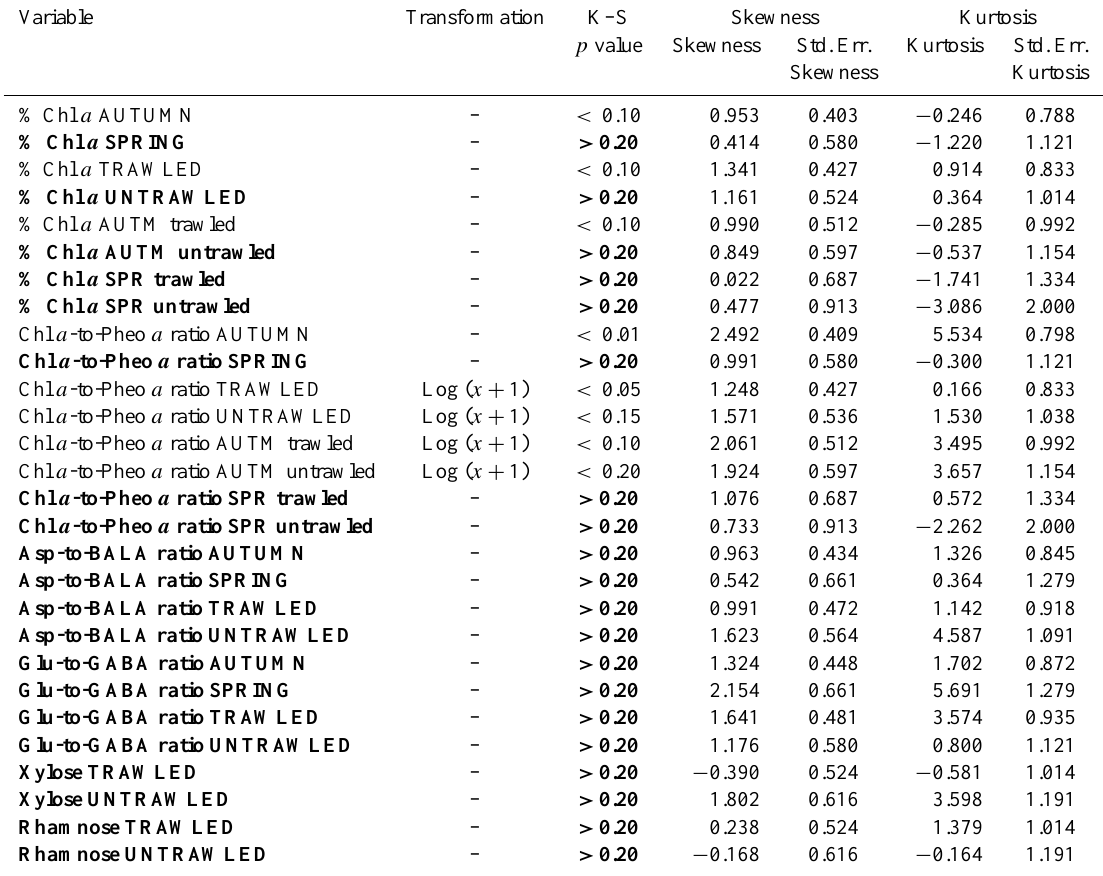
Table 2a. Results of the Kolmogorov–Smirnov test. Normality distributions are marked in bold. Variable